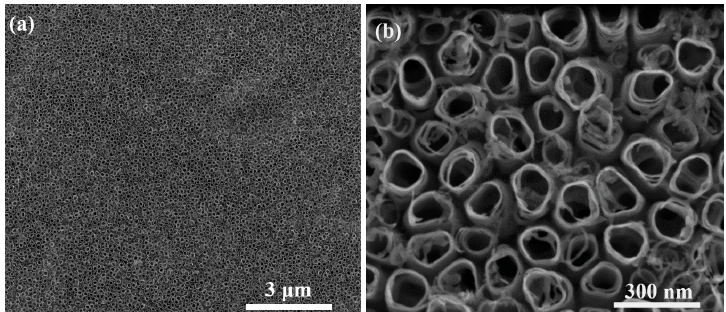
Figure 6. Top view of TiO 2 nanotubes after anodic oxidation procedure at 25 V in a glycerol-water mixture with ammonium fluoride electrolyte at low ( a ) and high magnification ( b ).